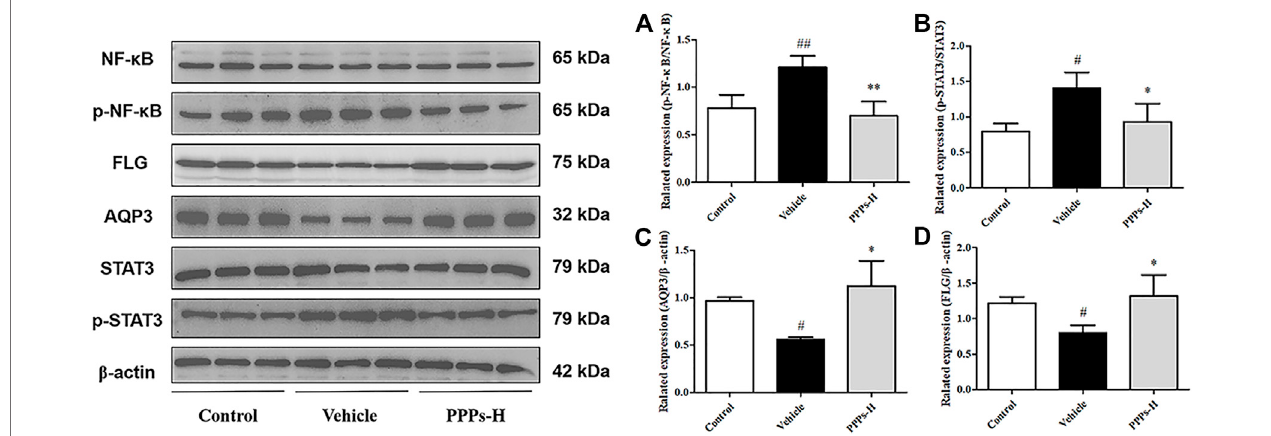
FIGURE 7 | Punica granatum peel polysaccharides (PPPs) suppressed aquaporin-3 (AQP3), fi laggrin (FLG), and the NF- κ B and STAT3 signaling pathways in skin with psoriatic lesions. Effect of PPPs on the translational expressions of p-NF- κ B, NF- κ B, p-STAT3, STAT3, AQP3, and FLG in the skin samples of mice with imiquimod (IMQ)-elicited psoriasis as determined by Western blotting post-treatment with PPPs. Densitometry analyses of the immunoblotting are shown as p-NF- κ B/NF- κ B (A) , p-STAT3/STAT3 (B) , AQP3/ β -actin (C) , and p-STAT3/ β -actin (D) . Data are shown as the mean ± SD ( n (cid:1) 3). # p < 0.05, ## p < 0.01 vs . the control group; * p < 0.05, ** p < 0.01 vs . the vehicle group. PPPs-L , low-dose PPPs; PPPs-H , high-dose